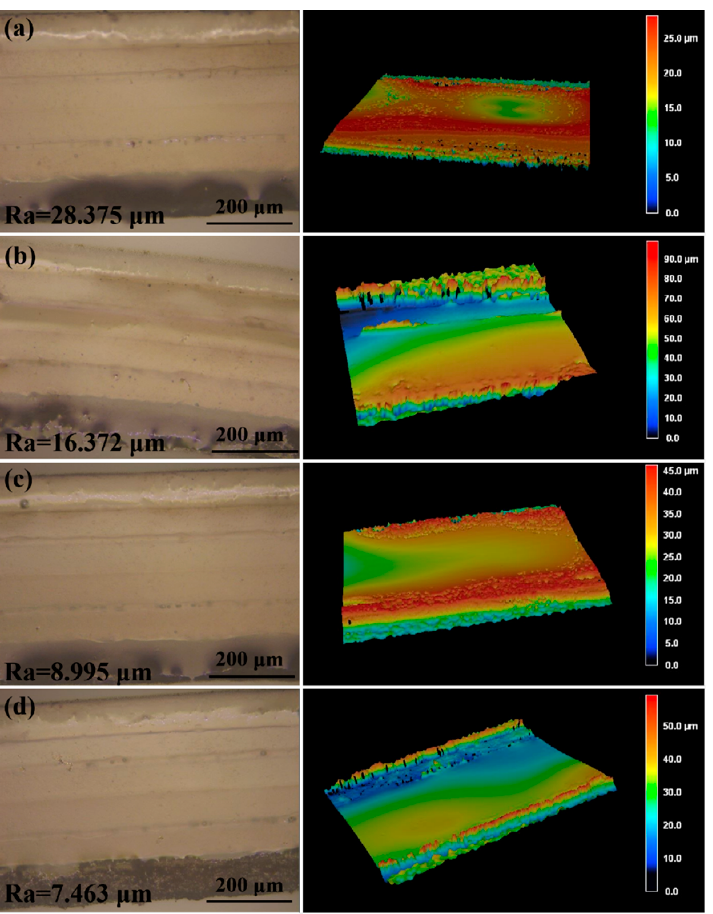
Figure 5. The laser scanning microscope images and the three-dimensional surface topography of the microchannels prepared at different laser cutting rates: ( a ) 10 mm/s, ( b ) 30 mm/s, ( c ) 40 mm/s and ( d ) 50 mm/s. The total processing time was similar.